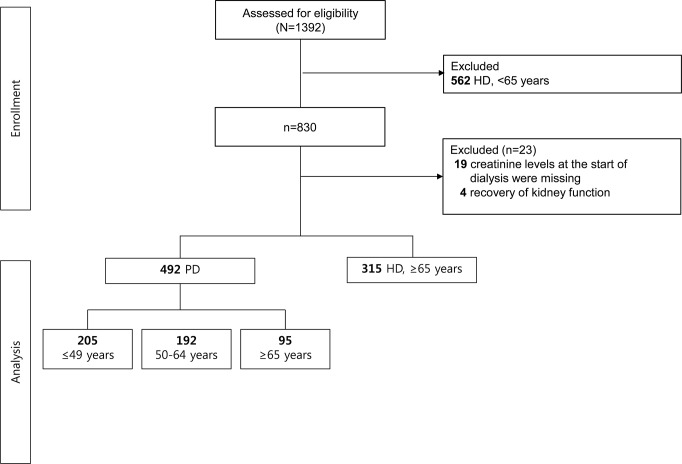
Study flow.492 patients undergoing PD were enrolled and divided into 3 groups according to age (≤49 years, n = 205; 50~64 years, n = 192; ≥65 years, n = 95); 315 HD patients aged ≥65 years were enrolled for comparison with elderly PD patients.